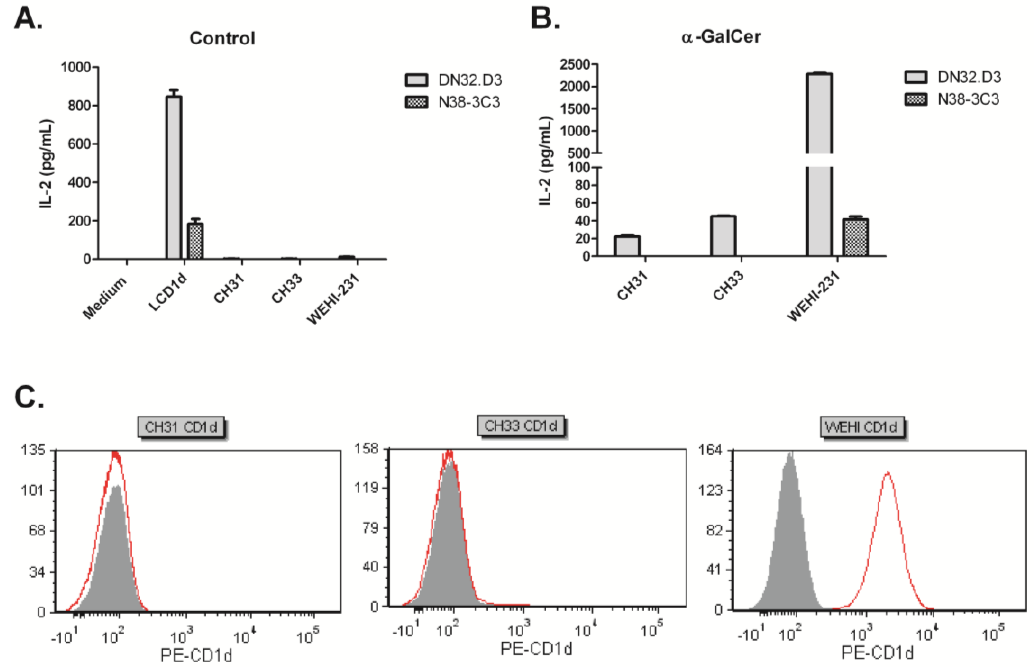
Figure 1. B cell lymphoma mediated activation of mouse NKT cell hybridomas. ( A ) Mouse B cell lymphoma lines (WEHI-231, CH31, and CH33) were cocultured with NKT cell hybridomas, DN32.D3 and N38-3C3. Recognition of CD1d was assessed by measuring IL-2 production in the supernatants by ELISA. L cells stably transfected with mCD1d1 (LCD1d) served as a positive control; ( B ) B cell lines were pulsed with the potent NKT cell agonist, α-GalCer (200 ng/mL for 2 h), washed extensively with PBS and co-cultured with NKT cell hybridomas; ( C ) Cell surface CD1d expression on mouse B cell lymphoma lines. Murine B cell lymphoma lines were analyzed for surface expression of CD1d by flow cytometry. Cells were stained with PE-labeled mouse CD1d specific clone 1B1 (red histograms), the gray filled histograms indicate the isotype